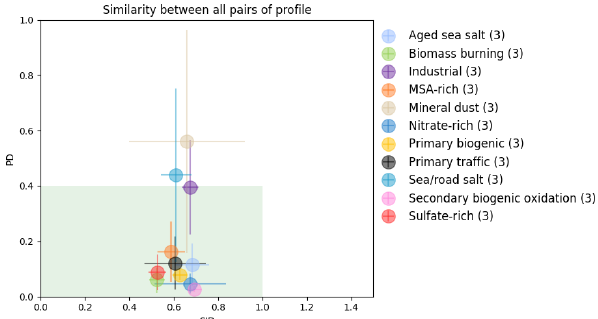
Figure 11. Similarity plot of all chemical profiles in each site. The shaded area (in green) shows the acceptable range of the PD-SID metric. For each point, the error bars represent the standard devia- tion of the three pairs of